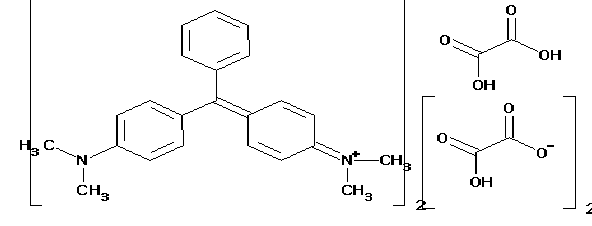
Figure 2. Structure of malachite green